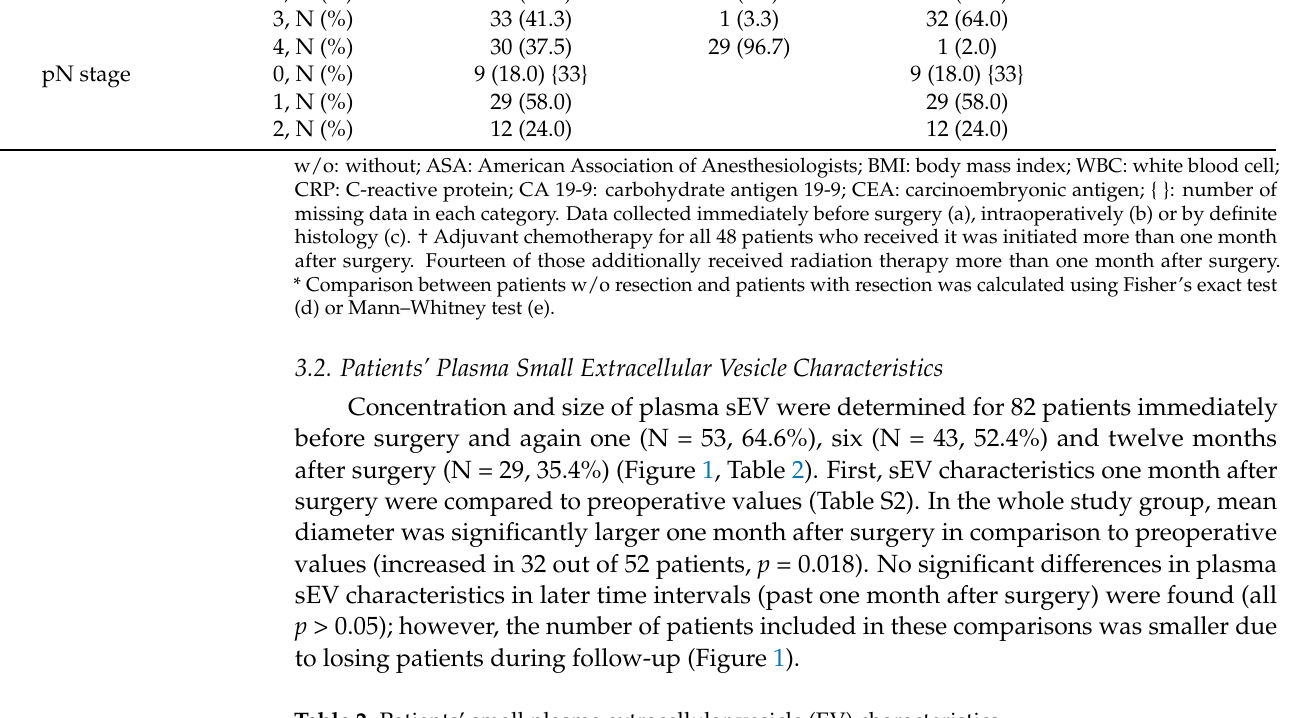
Table 2. Patients’ small plasma extracellular vesicle (EV)